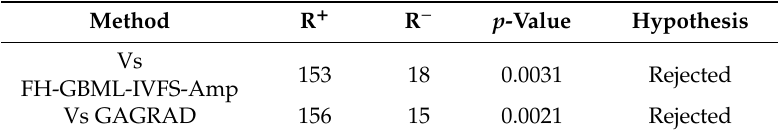
Table 7. Wilcoxon signed–ranks tests of the considered